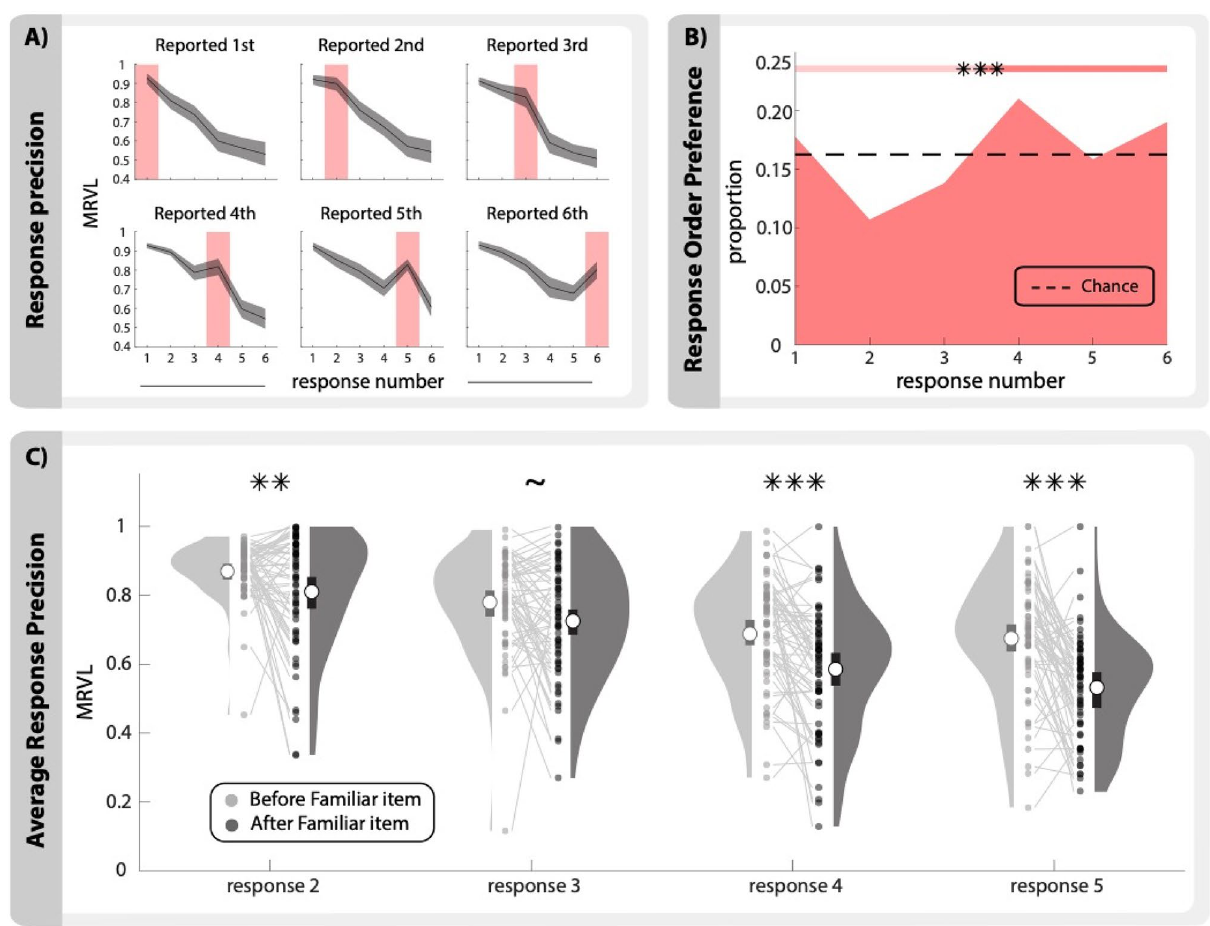
Figure 4. Bias in response order. ( A ) Precision for all items split by when the familiar item was reported. Red shaded area indicates responses to the familiar item. ( B ) Proportion of responses to familiar items at each response number where chance is 1/6 and shown by the dashed line. Colored area with significant markers indicates bins for binomial test. ( C ) Response precision (MRVL) for novel items at each response number split by relative order with the familiar item. Response number indicates when the novel item was reported while before and after indicate when the familiar item was reported (e.g. response 2 before would be all novel item responses reported second when the prior item was reported third or later). Only responses 2–5 are shown because responses 1 and 6 do not have both before and after responses. White circles indicate group means; bars indicate bootstrapped 95% CIs. Dots and connecting lines represent individual participants. (~ p < 0.05, ** p < 0.01, *** p <